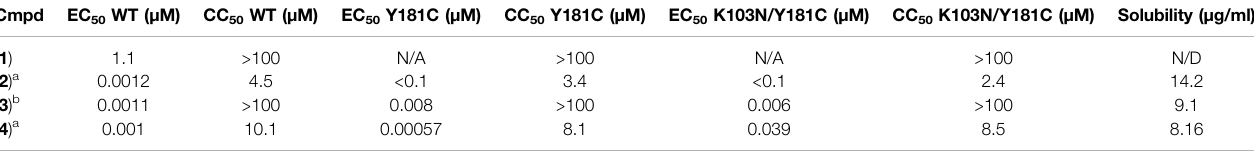
TABLE 1 | Antiviral data and solubility measurements for Compounds 1-4.